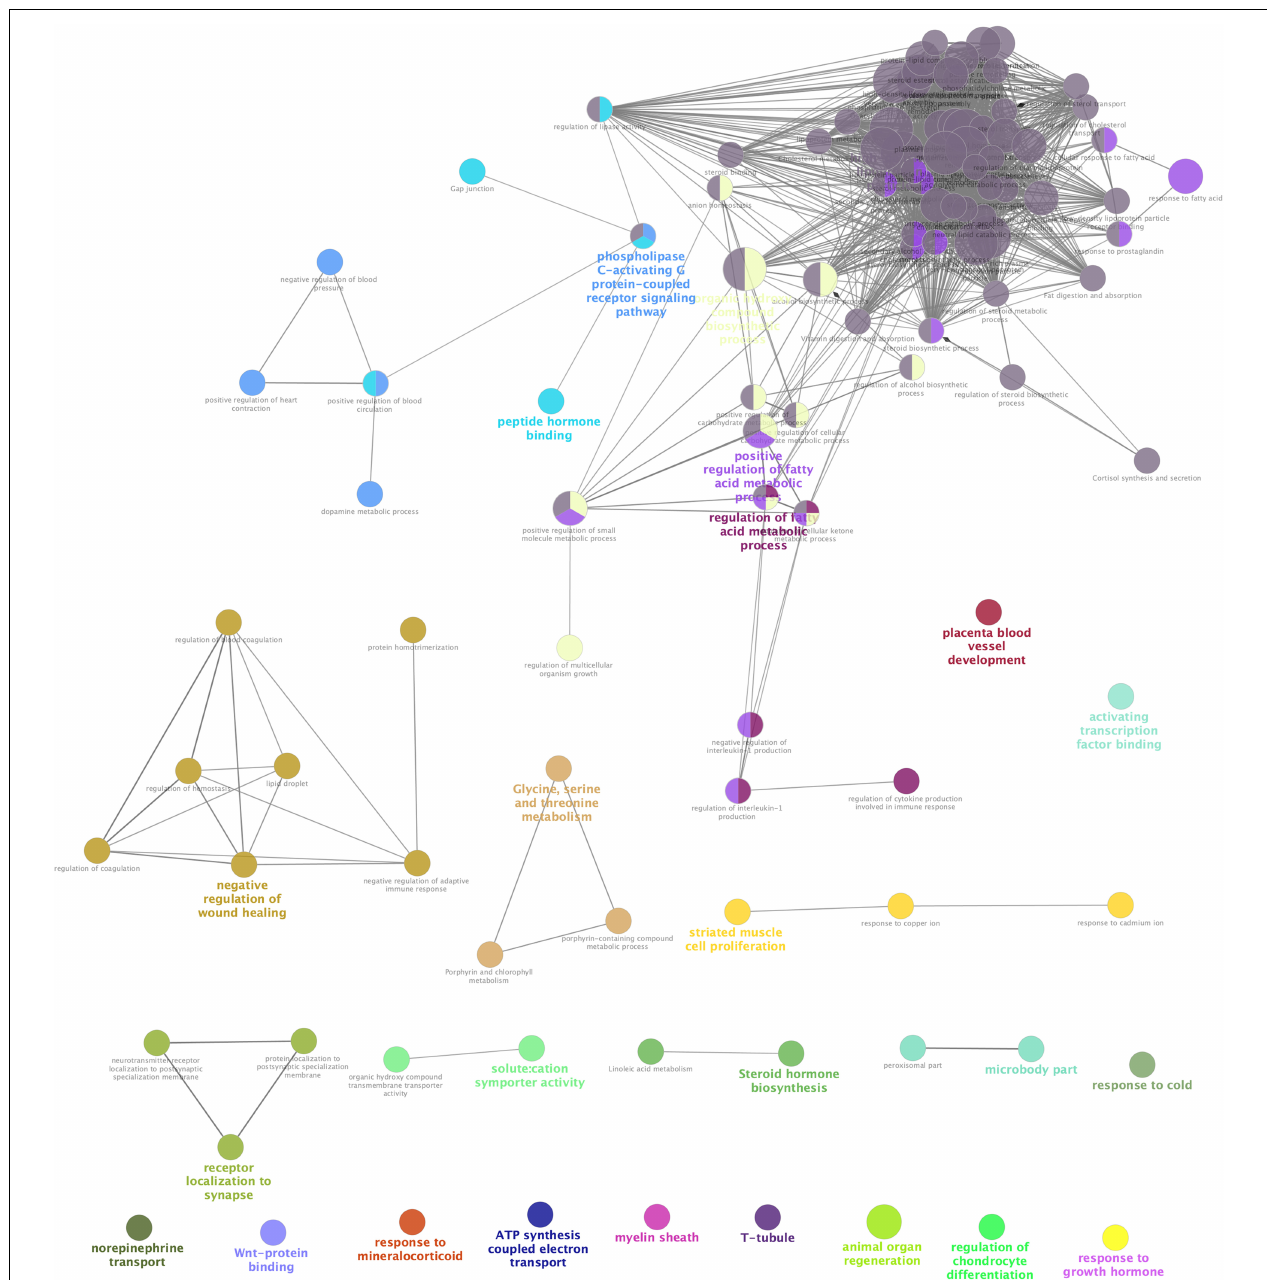
FIGURE 3 | Interrelation analyses between differential pathways between Acarbose and Water. The interrelation of biological process (GO), cellular component (GO), molecular function (GO), and KEGG for the differentially expressed genes (DEGs) between Acarbose and Water was analyzed using the ClueGo plugin in Cytoscape. Each node corresponded to a term, the size of the node corresponded to the universality of the term in the enriched genes, and the connection between the nodes showed the correlations between different terms. Modules in different colors represented different functions. The selection threshold for terms/pathways is p <